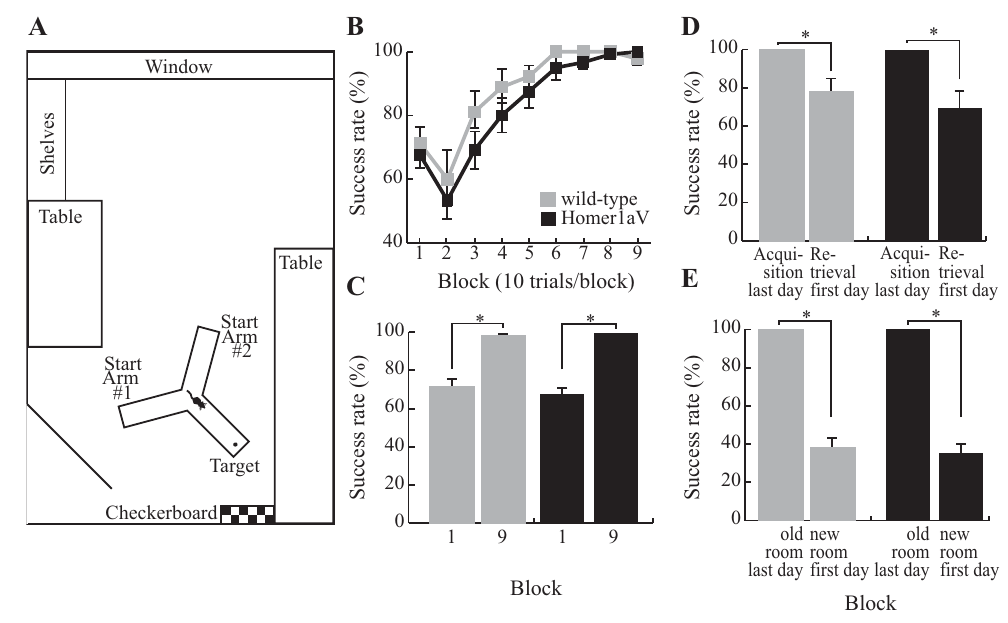
Figure 7. Sustained H1aV expression does not impair acquisition of spatial reference memory . ( A ) The maze was located in a room devoted to behavioral testing of mice. In addition to spatial landmarks in the room, a checkerboard pattern was placed in front of the target arm. ( B ) TgH1aV.Fb mice (N=12) did not differ from wild-type (N=9) during task acquisition and learned the task at similar speed and rate as the wild-type. ( C ) Both genotypes reached an asymptotic level of performance that was significantly better than their respective performances during the first training block. ( D ) After a 5 weeks break from training, the mice were retested in retrieval sessions. Both genotypes showed similar reduction in performance between the last testing block of the acquisition phase and the first block of the retrieval. ( E ) After the mice relearned the task, they were tested in a new room to control for the spatial cue dependence of the mouse behavior. The maze was arranged in the same orientation along the poles, but this time had new landmark cues in the new location. Success rate in the new room was at chance level for both genotypes.